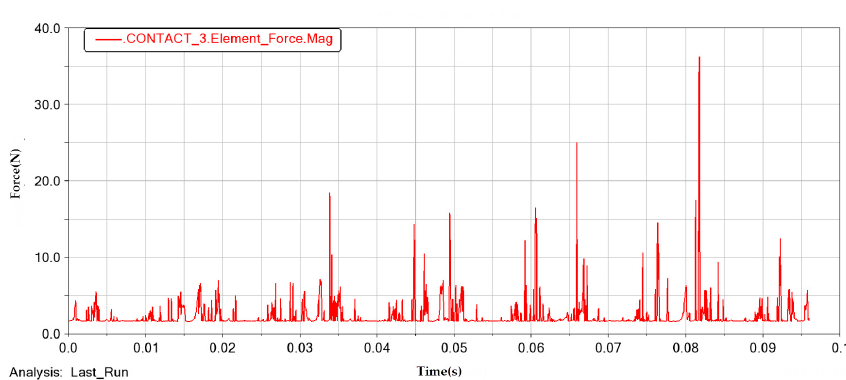
Figure 24. Second piston pin force curve.